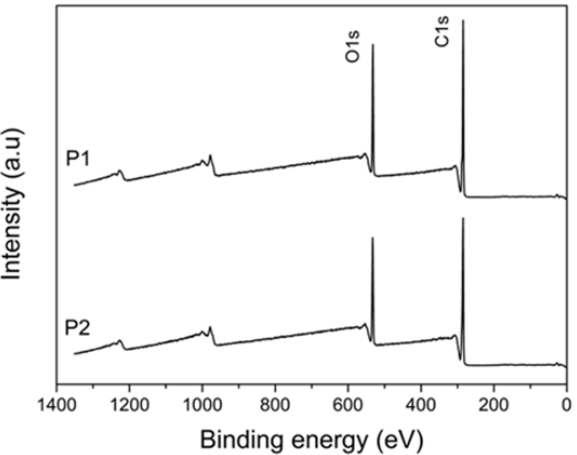
Figure 1. XPS spectra of plasticizers P1 and P2.